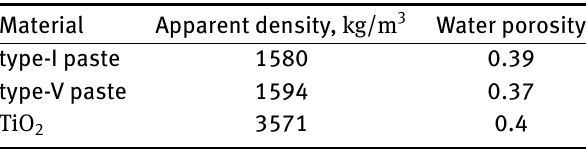
Table 1: Microstructure